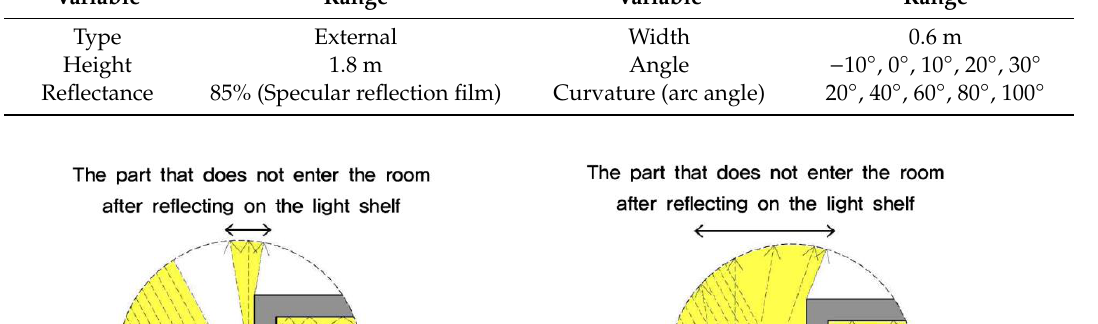
Figure 7. Fabrication and installation of a curved light shelf for performance evaluation.